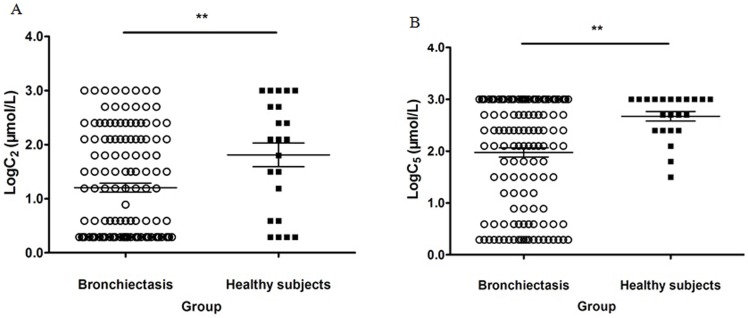
Distribution of Log10C2 and Log10C5 in bronchiectasis patients and healthy subjects.The capsaicin cough sensitivity, calculated as the capsaicin concentration causing at least 2 (C2) and 5 (C5), was compared between bronchiectasis patients and healthy subjects. Bronchiectasis patients yielded markedly lower levels of C2 and C5, suggesting significantly higher capsaicin cough sensitivity than healthy subjects. The lines of the bar in each figure represented the 25% percentile, median and 75% percentile, respectively. Figure 2-A, distribution of Log10C2, Figure 2-B, Distribution of Log10C5. The asterisks in both Figures 2-A and 2-B denoted P<0.01.